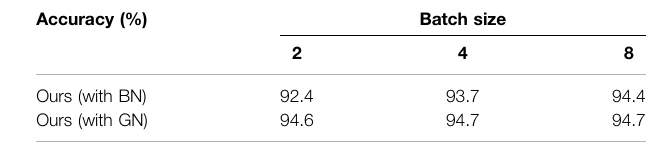
TABLE 4 | Results comparison on transmission line data set. TABLE 5| Classi fi cation accuracywith different normalization methods and batch